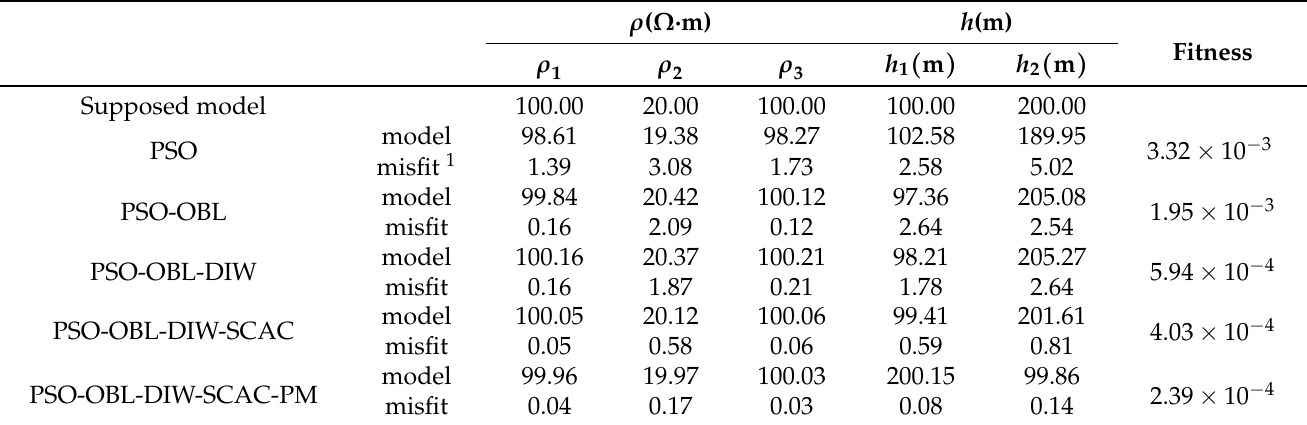
Table 1. Accuracy comparison of three-layer geoelectric model predicted by different